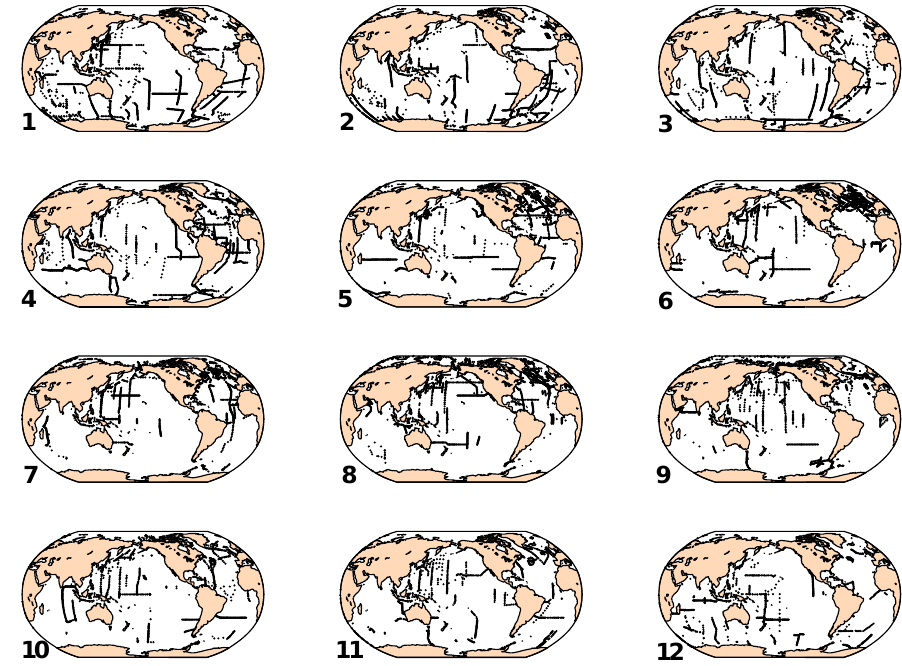
Figure 1. Monthly data density of TCO 2 in the years 1972–2013. The figure includes all data shallower than